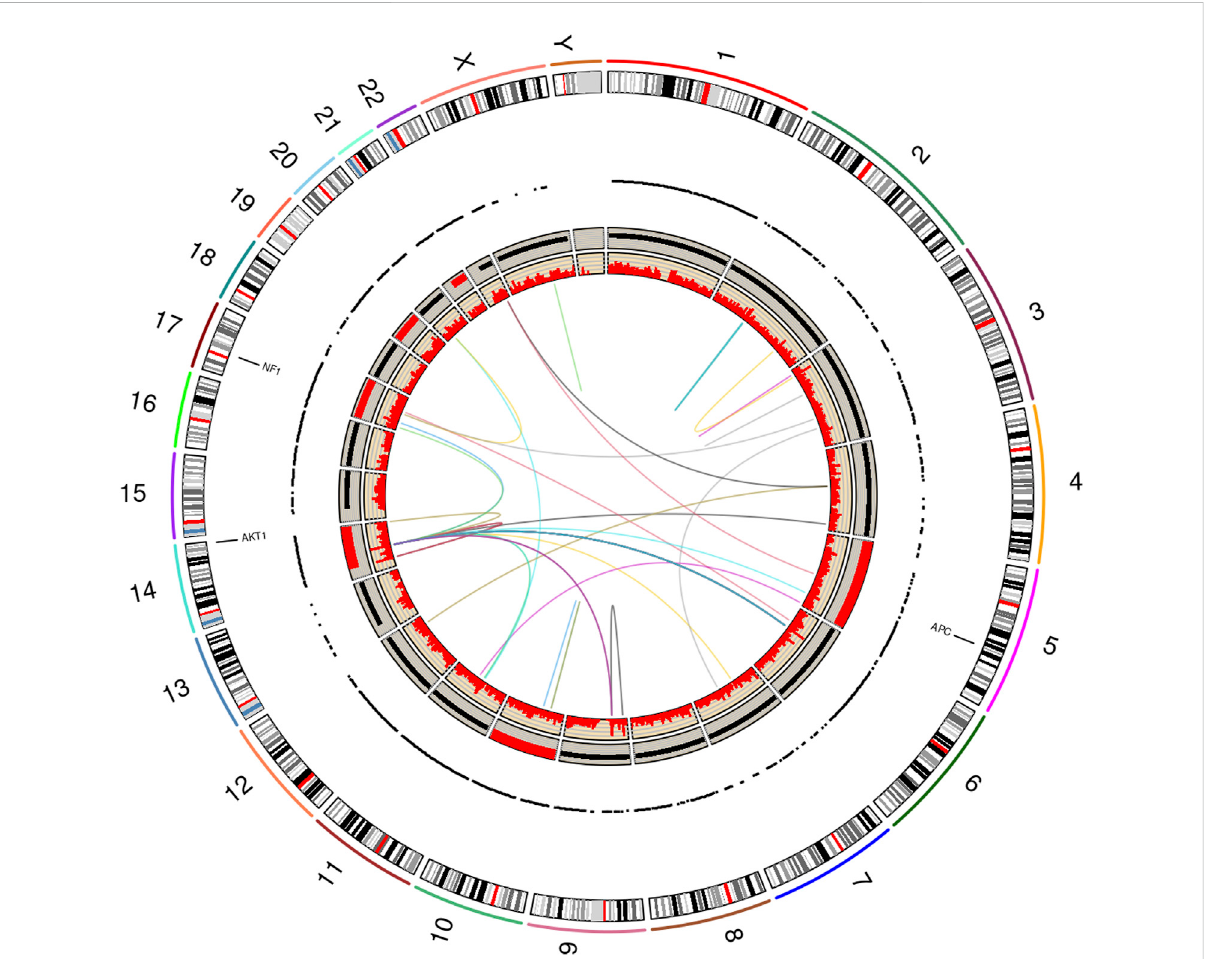
FIGURE 3 RCircos plot produced by the NGS Post-pipeline Accuracy and Reproducibility System (NPARS). This fi gure summarizes and integrates seven genomics methods into one graphical plot. From the outermost ring inward: (i) human chromosomal ideogram, (ii) DNA panel mutations (tumor vs. germline), (iii)RNAexpressedmutationsfromthefulltranscriptome, eachdotrepresents aRNAexpressed mutation (depthgreaterthanorequal 10), (iv)wholegenomeDNAcopynumbervariations(tumorvs.germline)withredrepresentingacopynumbergreaterthan2,copynumberequalto 2 by black coloring, and a copy number smaller than 2 by blue, (v) RNA gene expression (TPM) and, (vi) RNA gene